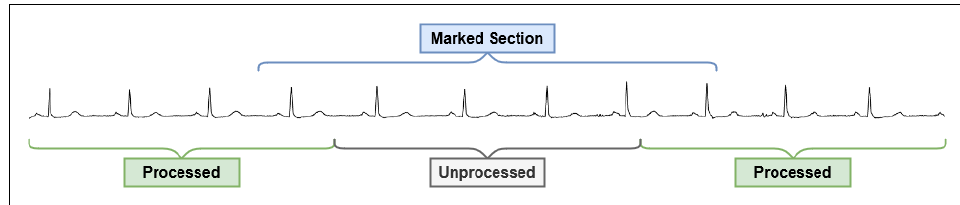
Figure 4. Marking of data sections that have not been processed.